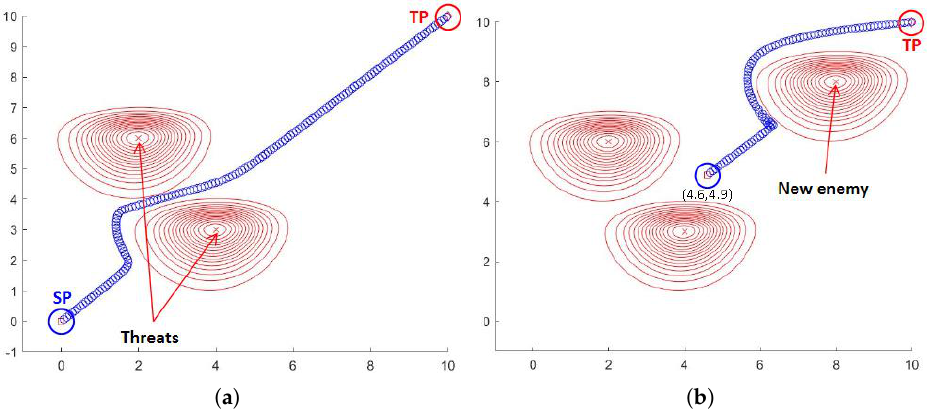
Figure 8. Path planning in a contingency situation: ( a ) initial state with two enemy threats; ( b ) contingency situation: a new enemy